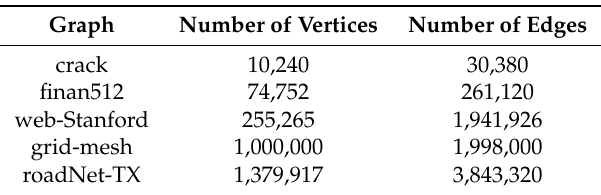
Table 1. Summary of the five tested graphs.